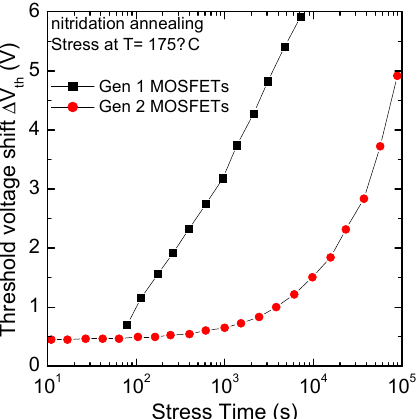
Figure 9. Vth shift as a function of the gate bias stress time at 175 ◦ C for two di ff erent device families: Gen1 and Gen2 commercial 4H-SiC MOSFETs. The data are taken from Reference